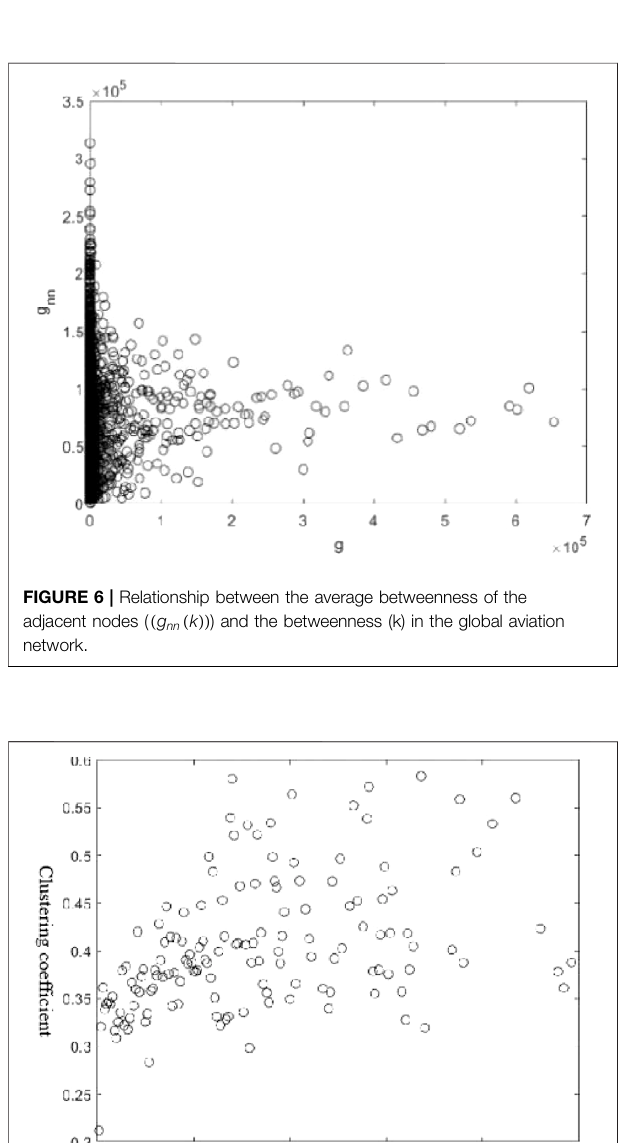
FIGURE 5 | Relationship between the average degree of the adjacent nodes ( k nn ( k )) and the degree (k) in the global aviation network.